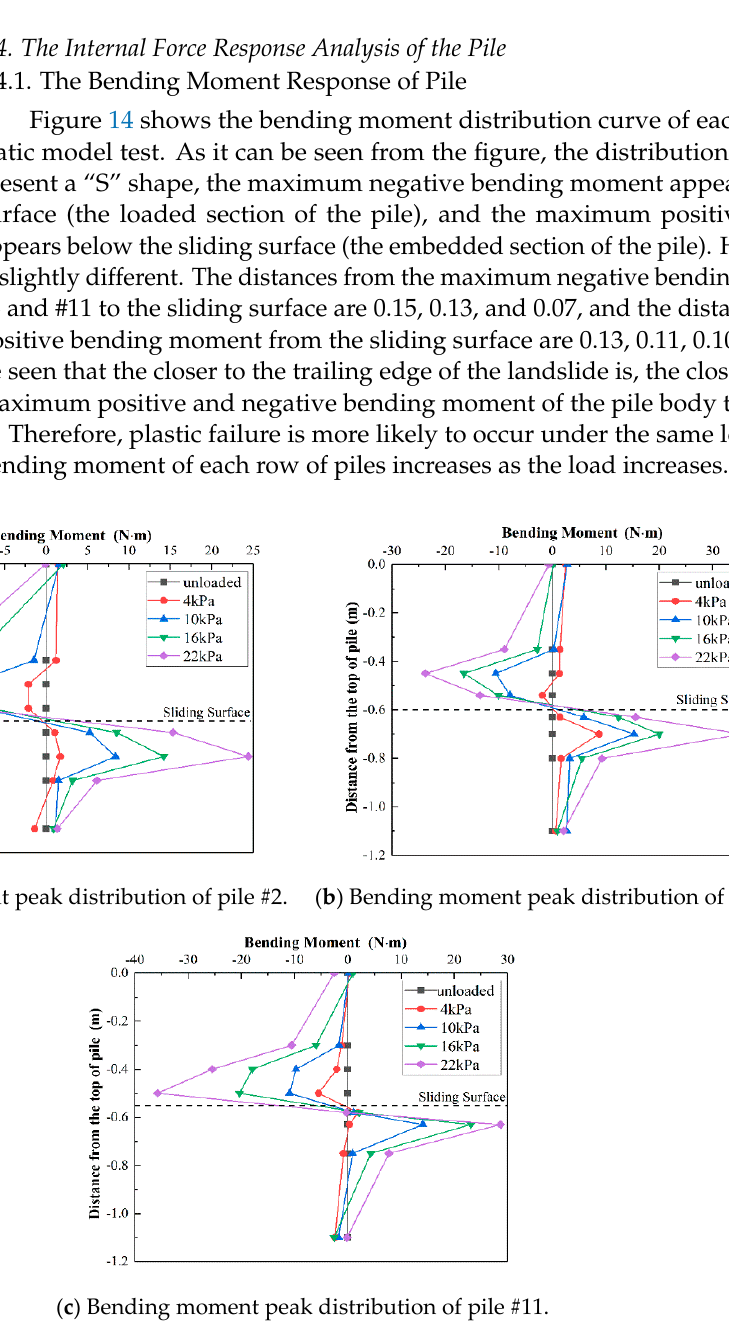
Figure 14. Bending moment distribution of each row of piles (static model